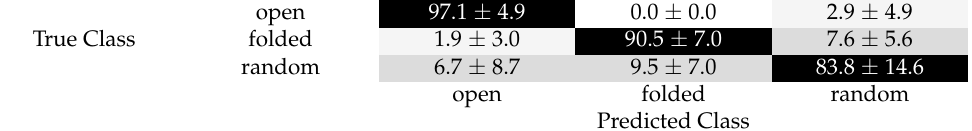
Figure 7. Definition of the “open” and “folded” states of the instrumented shorts. ( a ) “Open” state of the shorts; ( b ) intermediate step between “open” and “folded” states; ( c ) “folded” state of the shorts. Table 3. Confusion matrix of the average test scores, normalized rows. All values are